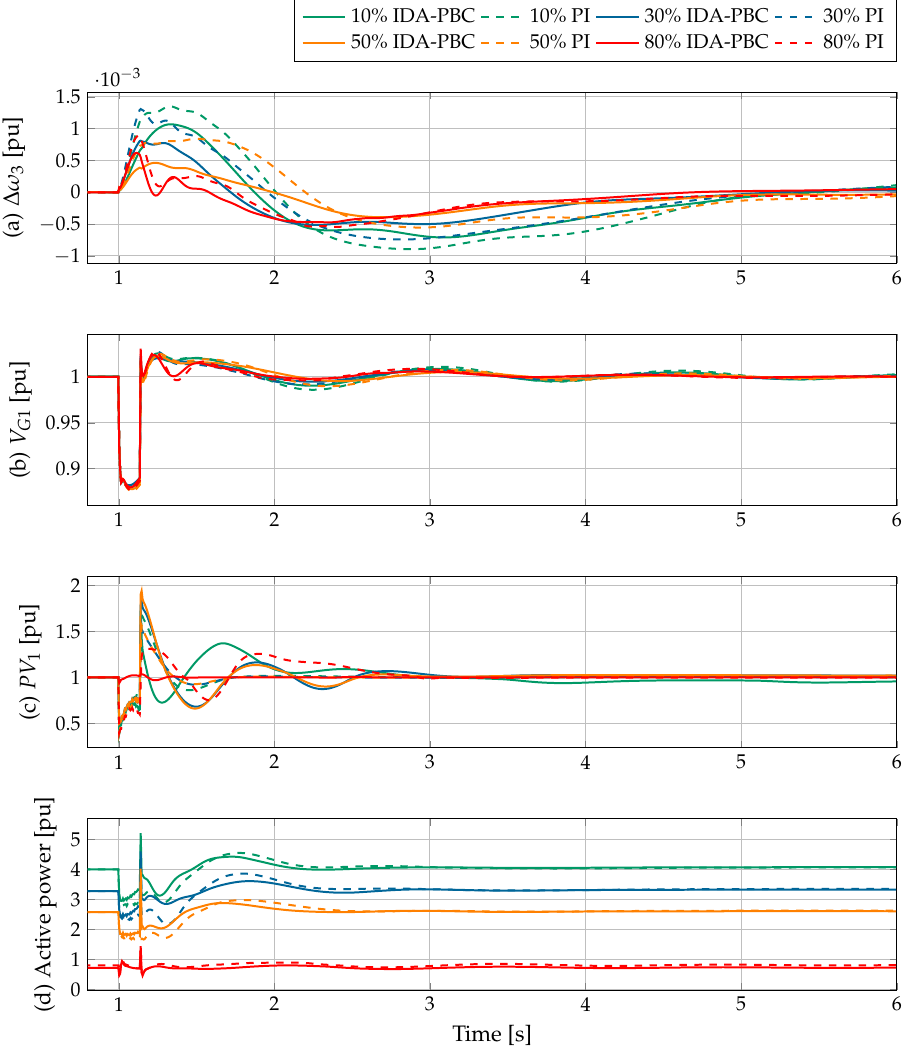
Figure 9. Response of the test system to a short circuit in the middle of line L-2: ( a ) rotor speed of generator 3, ( b ) terminal voltage of generator 1, ( c ) active power of PV plant 1, and ( d ) active power of generator